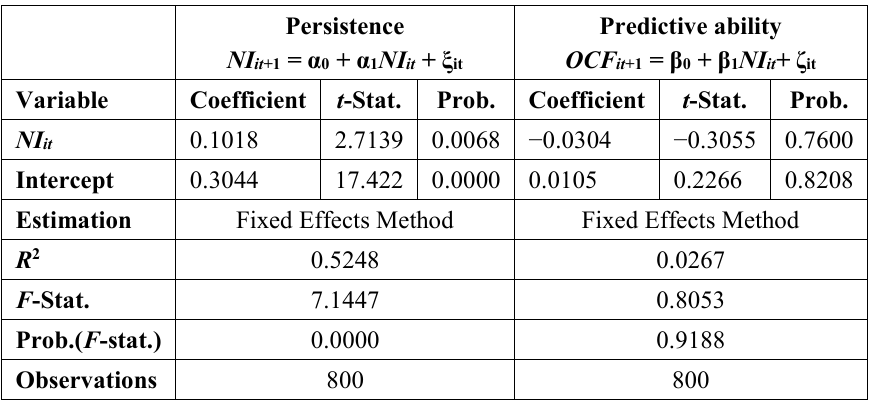
Table 4. The Model Estimation Results in UK